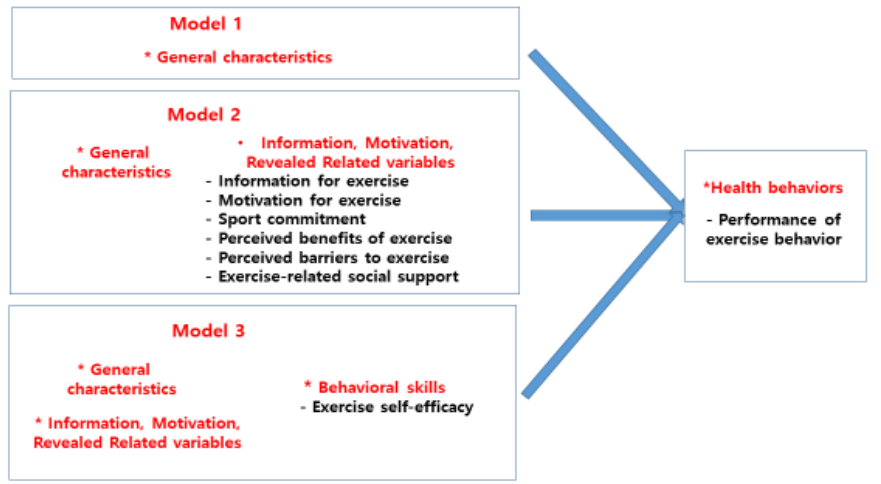
Figure 1. Conceptual framework for this study. * equals spot. There is no special meaning.